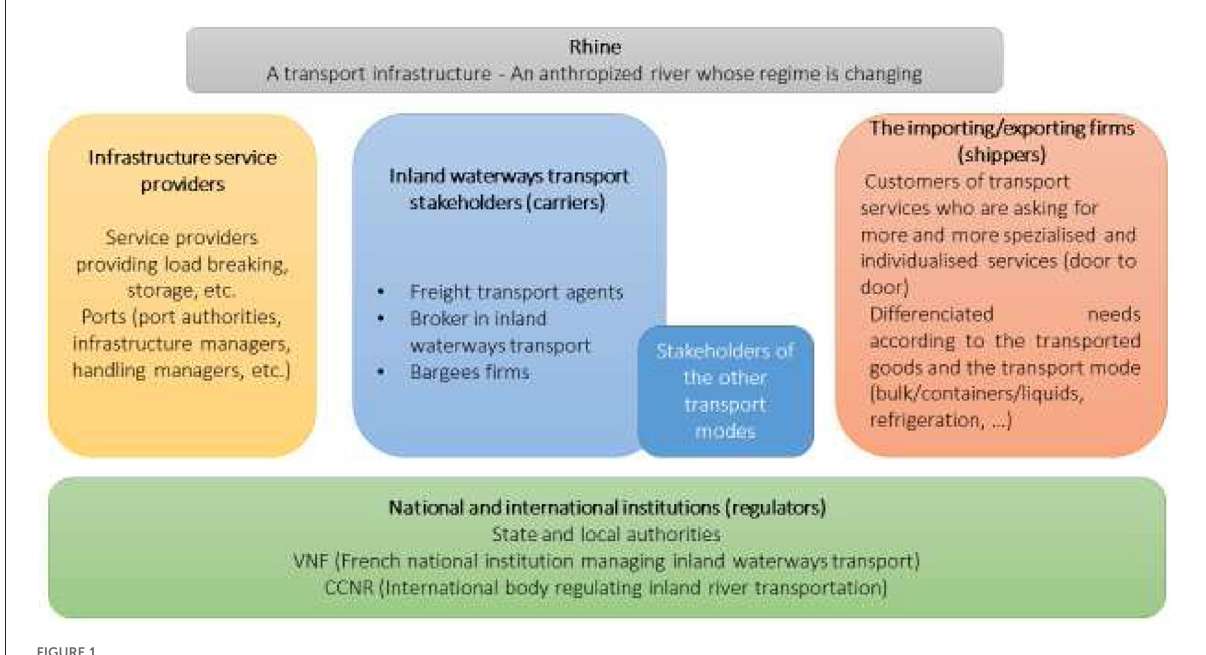
FIGURE1 The different stakeholders involved in the process and impacted by low